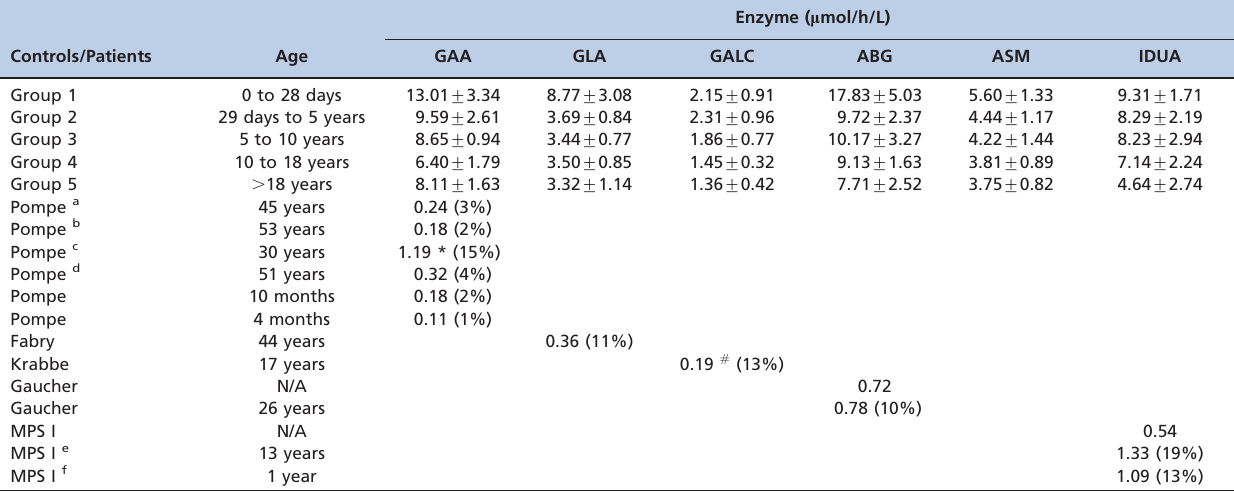
Table 1 - Lysosomal storage disorder enzyme activities of individuals according to age. Data are expressed as the median ¡ median absolute deviation. The percent residual enzyme activities in affected patients according to their age groups are shown in